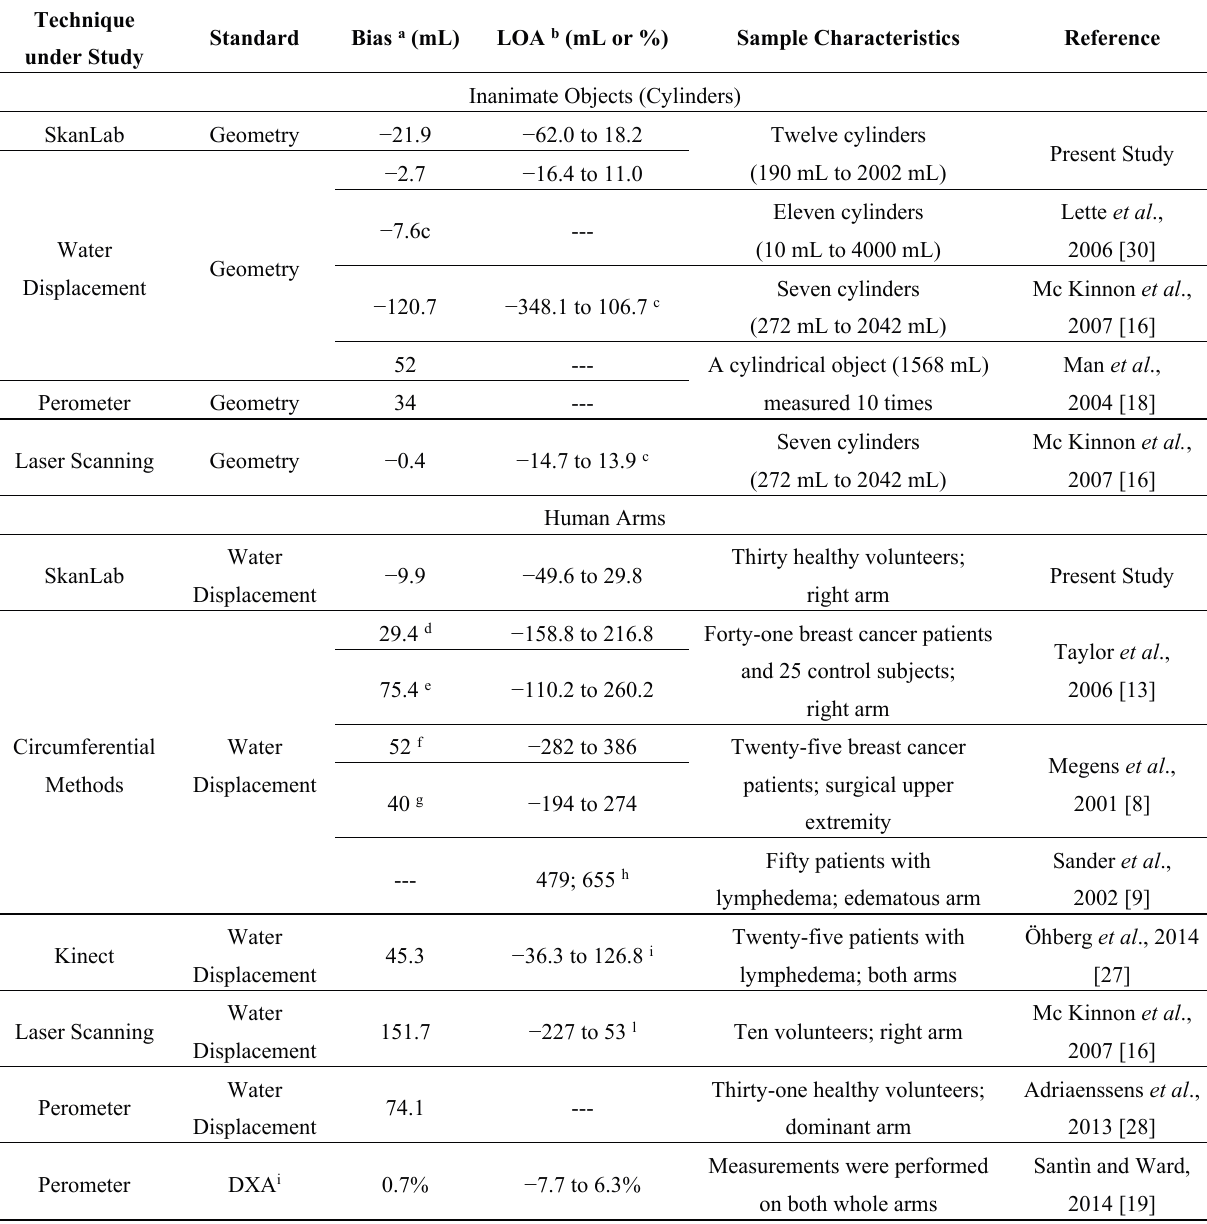
Table 7. Summary of literature results on